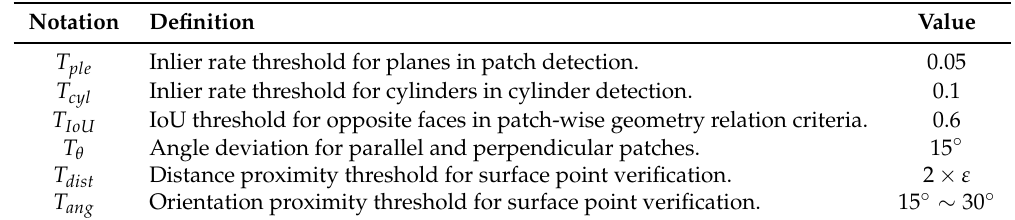
Table 1. Thresholds used in our detection scheme. IoU, intersection over union.